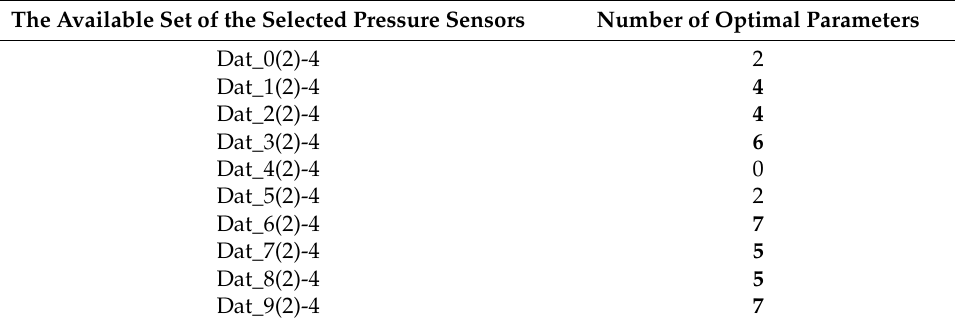
Table 5. The selection of the best sensor among sensors numbered 2. The Available Set of the Selected Pressure Sensors